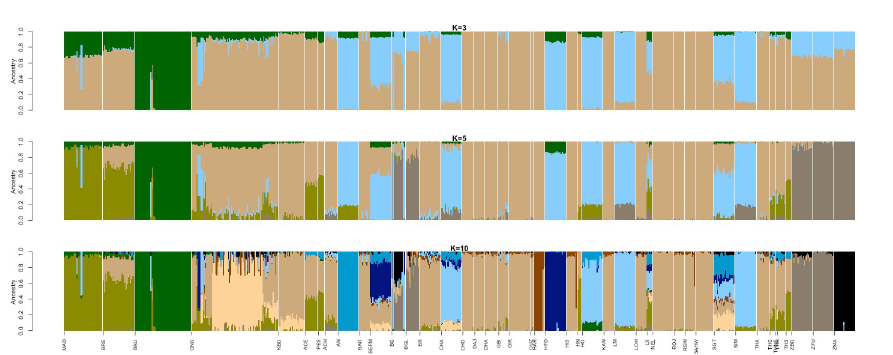
Fig 3. Ancestry models for Indonesian cattle in the worldwide population context. Each vertical line represents one individual. Breed names were abbreviated as in S1 Table. Every K is model referred to the number of estimated ancestors, which were defined by the colors. Model was started from K = 3 and defined Bos javanicus (dark green), indicine (light brown), and taurine (light blue) ancestries. K = 10 was a sensible modeling choice based on error cross- validation